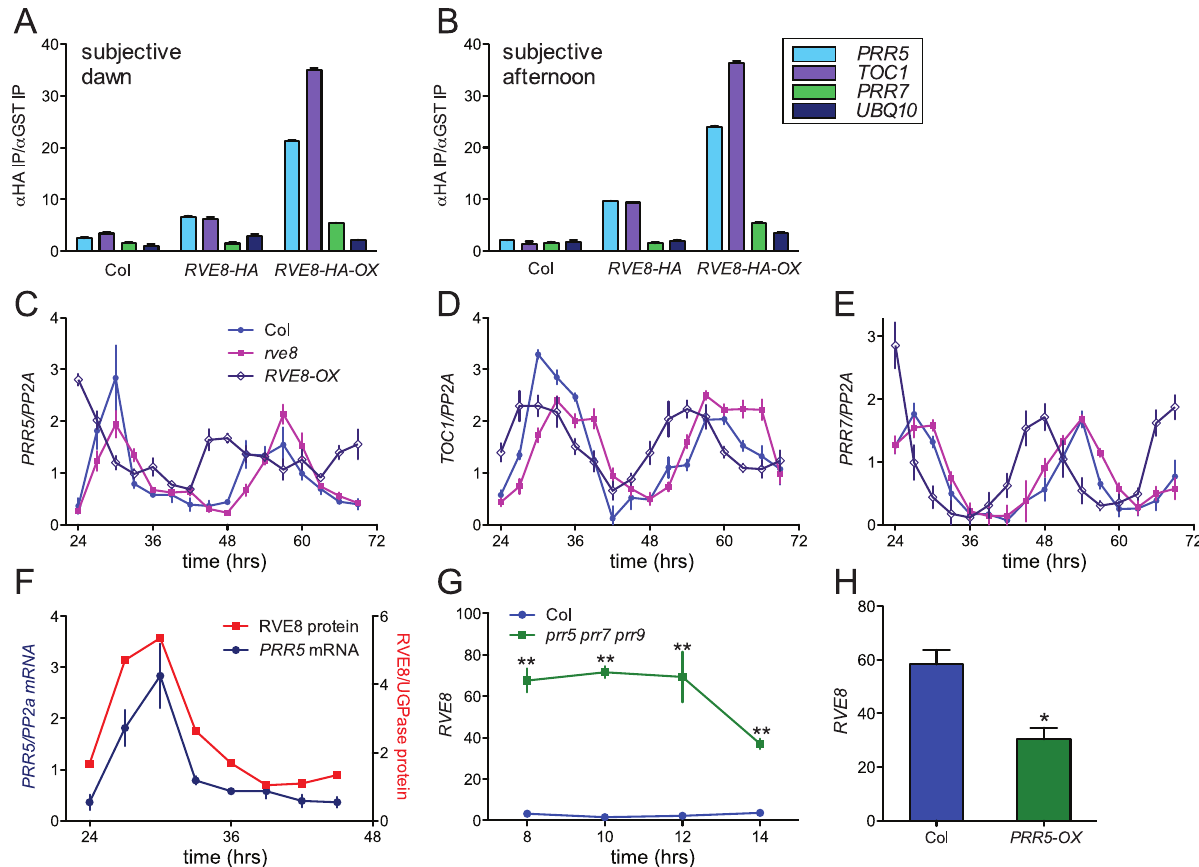
Figure 8. RVE8 and PRR5 form a negative feedback loop. (A, B) RVE8 binds to promoter regions containing EE motifs. Col, rve8-1 + RVE8::RVE8- HA and rve8-1 + 35S::RVE8-HA seedlings were entrained in white light/dark cycles for six days before release into continuous red light (35 mol m 2 2 sec 2 1 ). Plants were harvested at ZT48 (A) or ZT 32 (B); chromatin immunoprecipitations (IPs) were carried out using anti-HA and anti-GST antibodies. qRT-PCR was performed using primers that amplify the EE-containing regions of the PRR5 and TOC1 promoters and the CBS-containing region of the PRR7 promoter; primers that amplify a portion of the UBQ10 locus were used as a background control. The ratios of the amount of DNA isolated in the anti-HA IPs vs. the control anti-GST IPs are presented. (C–E) Expression of clock-associated genes in Col, rve8-1 and RVE8-OX . Plants were entrained as described for panels A–B and samples were harvested at the indicated times. Expression of PRR5 (C), TOC1 (D), and PRR7 (E) was determined using qRT-PCR. Values are expressed relative to PP2a . Similar results were obtained in two independent experiments. (F–H) Regulatory interactions between RVE8 and PRR5. (F) Relative abundance of RVE8 protein and PRR5 mRNA (re-plotted from Figure 4B and Figure 8C). (G) RVE8 transcript levels are elevated in prr5 prr7 prr9 mutants; data are derived from previously-published microarray data [84,85]. (H) RVE8 transcript levels are reduced in plants expressing PRR5 under the control of the strong viral 35S promoter. Data are derived from microarray data available at NASC (submitted by Hitoshi Sakakibara; NASCArrays experiment reference number NASCARRAYS-420). ** indicates p , 0.01 and * indicates p , 0.05; Student’s two-tail heteroscedastic t test. Error bars represent 6 SE.